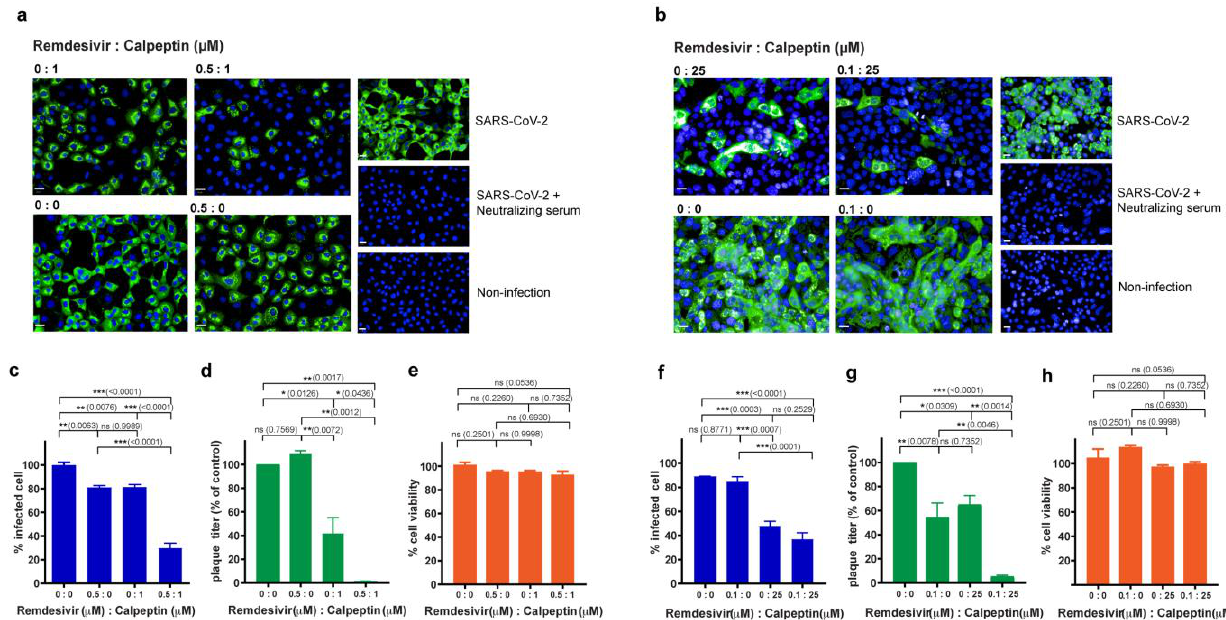
Figure 5. Effects of calpeptin and remdesivir combination on anti-SARS-CoV-2 activity in Vero E6 and Calu-3 cells. Cells were infected with SARS-CoV-2 at 25TCID50 for 2 h and then post-infection treated-indicated concentration of remdesivir ( µ M):calpeptin ( µ M). Positive convalescent serum of a COVID-19 patient was included as the positive control, and mock infection was performed in parallel as a negative control. The supernatant was collected for viral output quantification. The infected cells were fixed and stained for viral nucleoproteins with anti-SARS-CoV NP mAb. The SARS-CoV-2-infected cells were detected by high-content imaging. The high-content images of combination treatment in SARS-CoV-2 infected Vero E6 ( a ) and Calu-3 ( b ) cells are shown. The percentage of infected Vero E6 ( c ) and Calu-3 ( f ) was calculated and present at the indicated concentrations. The amounts of infectious virions in the supernatant of infected Vero E6 ( d ) and Calu-3 ( g ) cells were quantified by plaque assay, and data were presented as the percentage of the control. The percentage of cell viability of Vero E6 ( e ) and Calu-3 ( h ) are shown. The data are presented as the mean ± SEM of three biological replicates. Statistical analysis was performed by using one-way ANOVA with Tukey post hoc test: * p < 0.05, ** p < 0.005, and *** p < 0.001, ns, not significant. Scale bar: 20 µm.